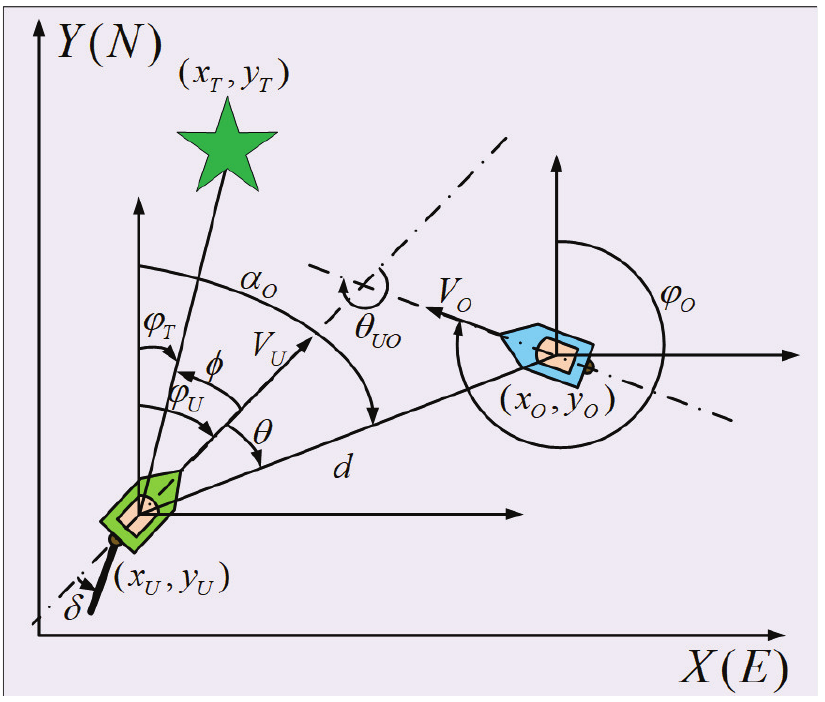
Figure 1. USV collision avoidance